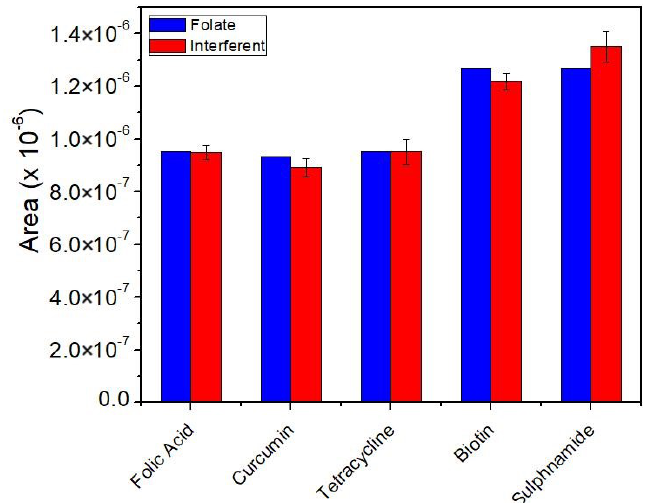
Figure 10. Interference analysis using the MMIP/CPE sensor in the presence of folate and other interfering compounds in the concentration range of 1:1.